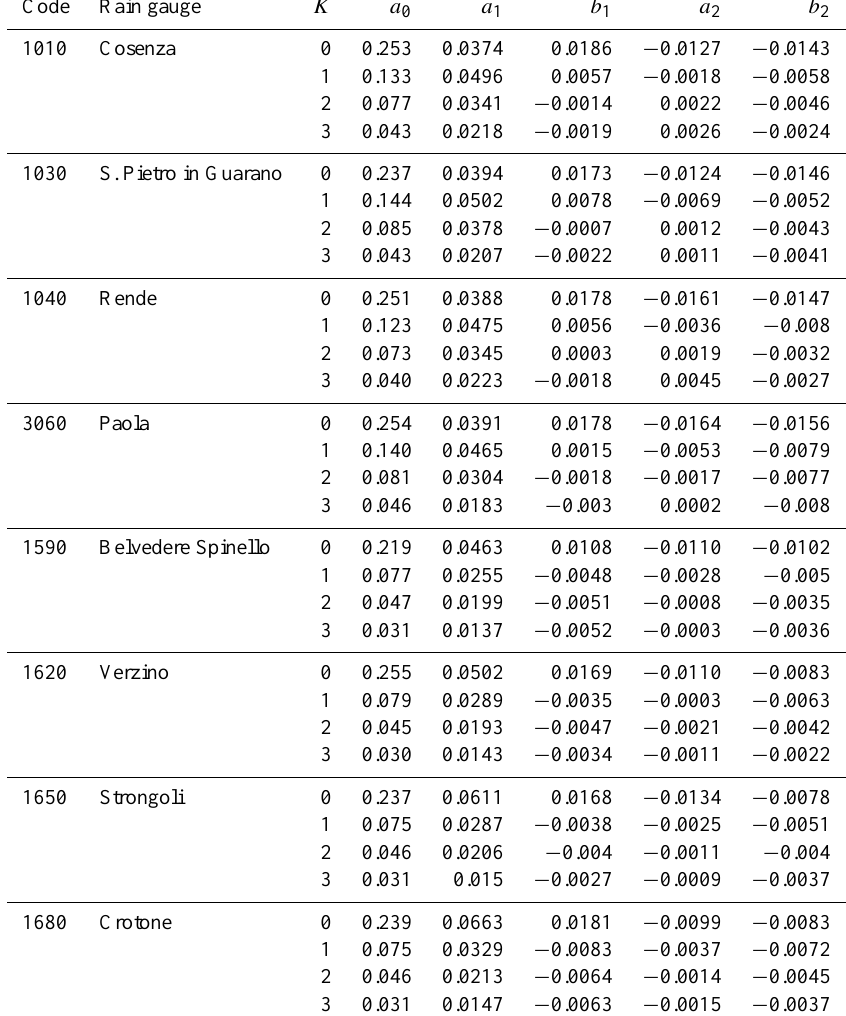
Table 2. Parameters estimation for non-homogeneous Poisson model through least square method applied to daily rainfall occurrence process (data belong to the calibration period 1921–1986; Fourier series with n h = 2